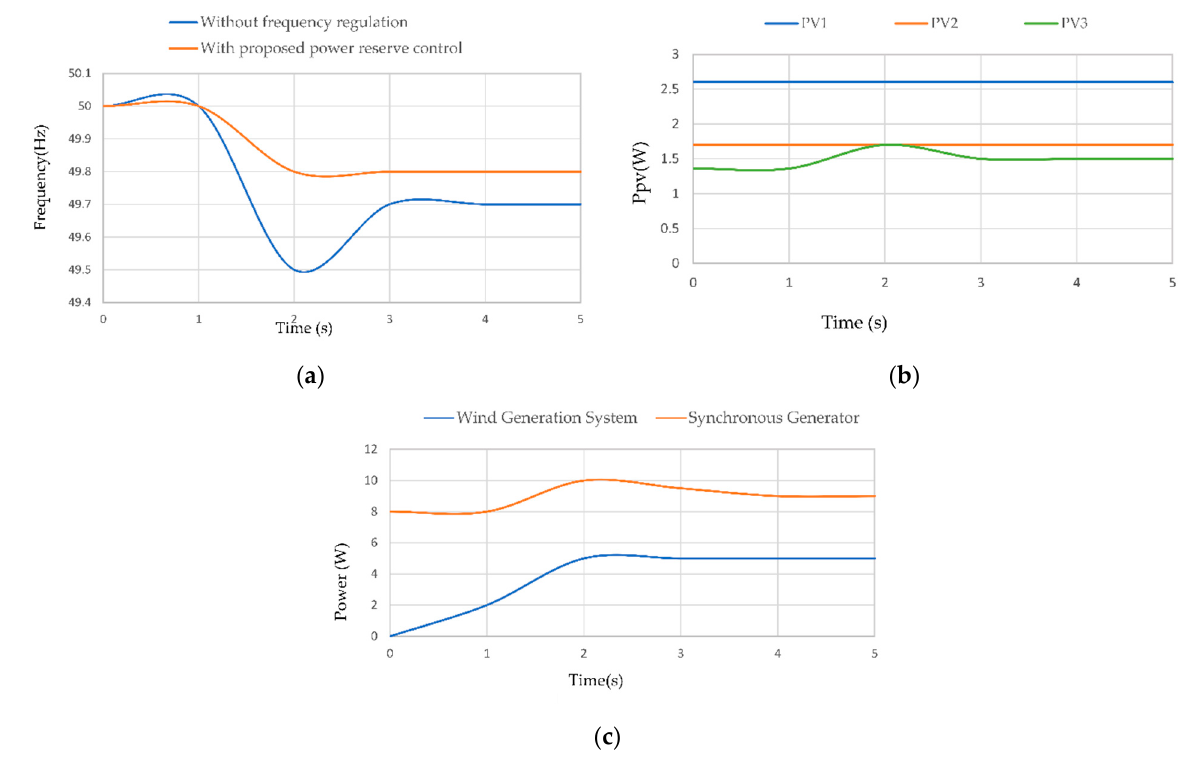
Figure 12. System output waveforms when the load is incremented by 0.5 MW: ( a ) Frequency; ( b ) PV power output; ( c ) output of wind generation system and synchronous generator.